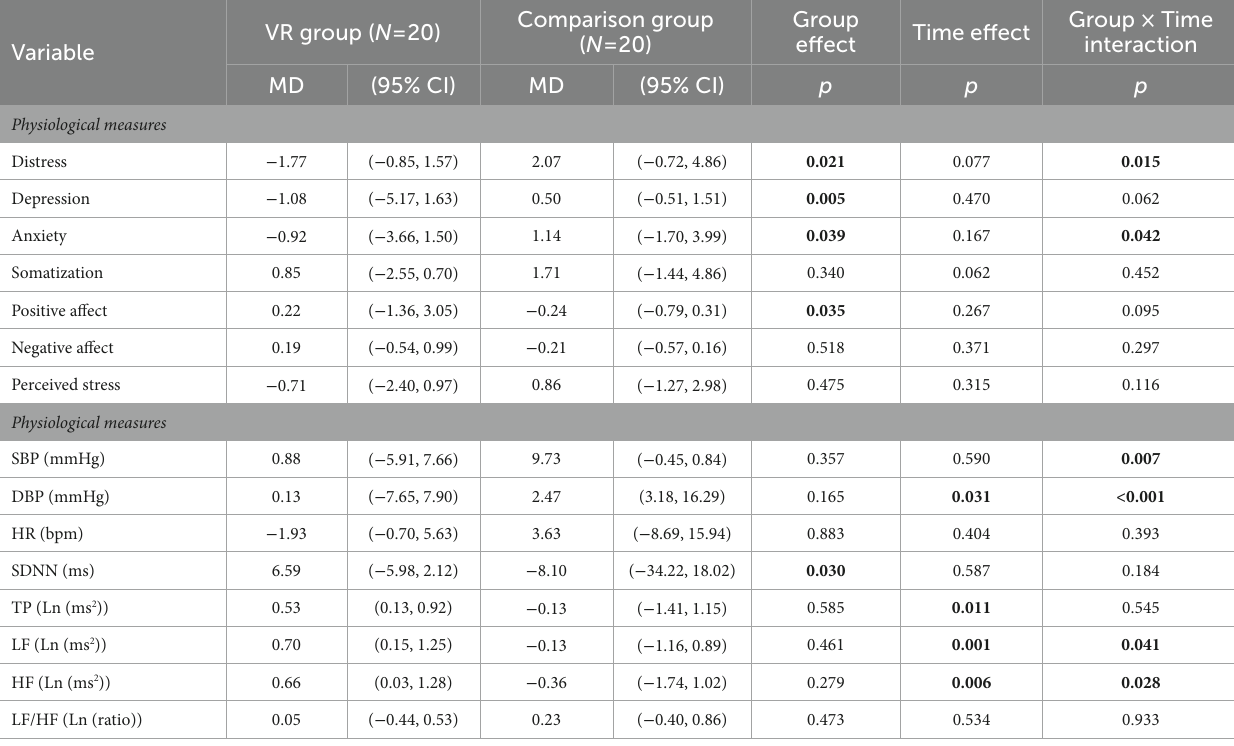
TABLE 3 Results of the generalized estimating equation